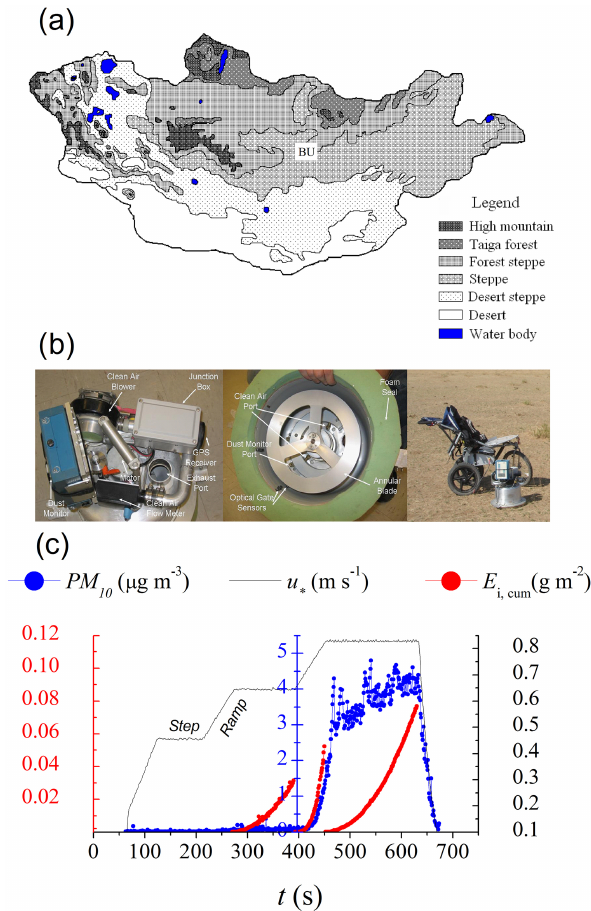
Figure 1. (a) BU (Bayan-Önjüül) denotes the location of the study site with respect to vegetation zones in Mongolia. (b) Pictorial il- lustrations of PI-SWERL ® ; top view on the left, bottom view in the middle, and in the field on the right side. (c) An example data trace of PM 10 concentration and the cumulative dust emissions ( E i, cum ) associated with friction velocity ( u ∗ ) during the PI-SWERL ® mea- surement period ( t